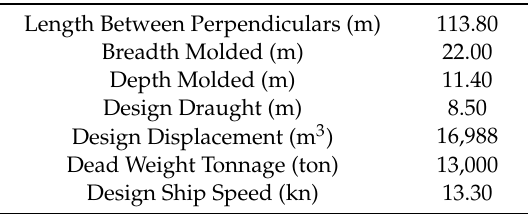
Table 1. Ship particulars of the benchmark chemical tanker.